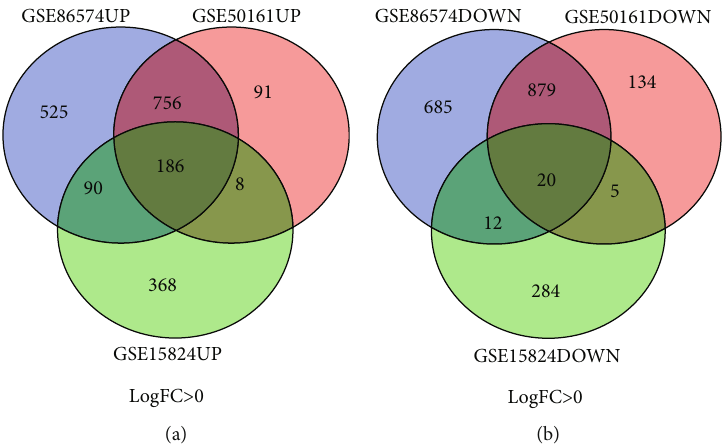
Figure 1: The Venn diagram software identi fi ed 206 common genes among the three datasets (GSE15824, GSE50161, and GSE86574). Distinct colors in the fi gure display di ff erent datasets. (a) In the three datasets, 186 DEGs were upregulated ( logFC > 0 ). (b) In the three datasets, 20 DEGs were downregulated ( logFC < 0 ). Table 1: An investigation of the GO of upregulated genes related to LGGs. Term